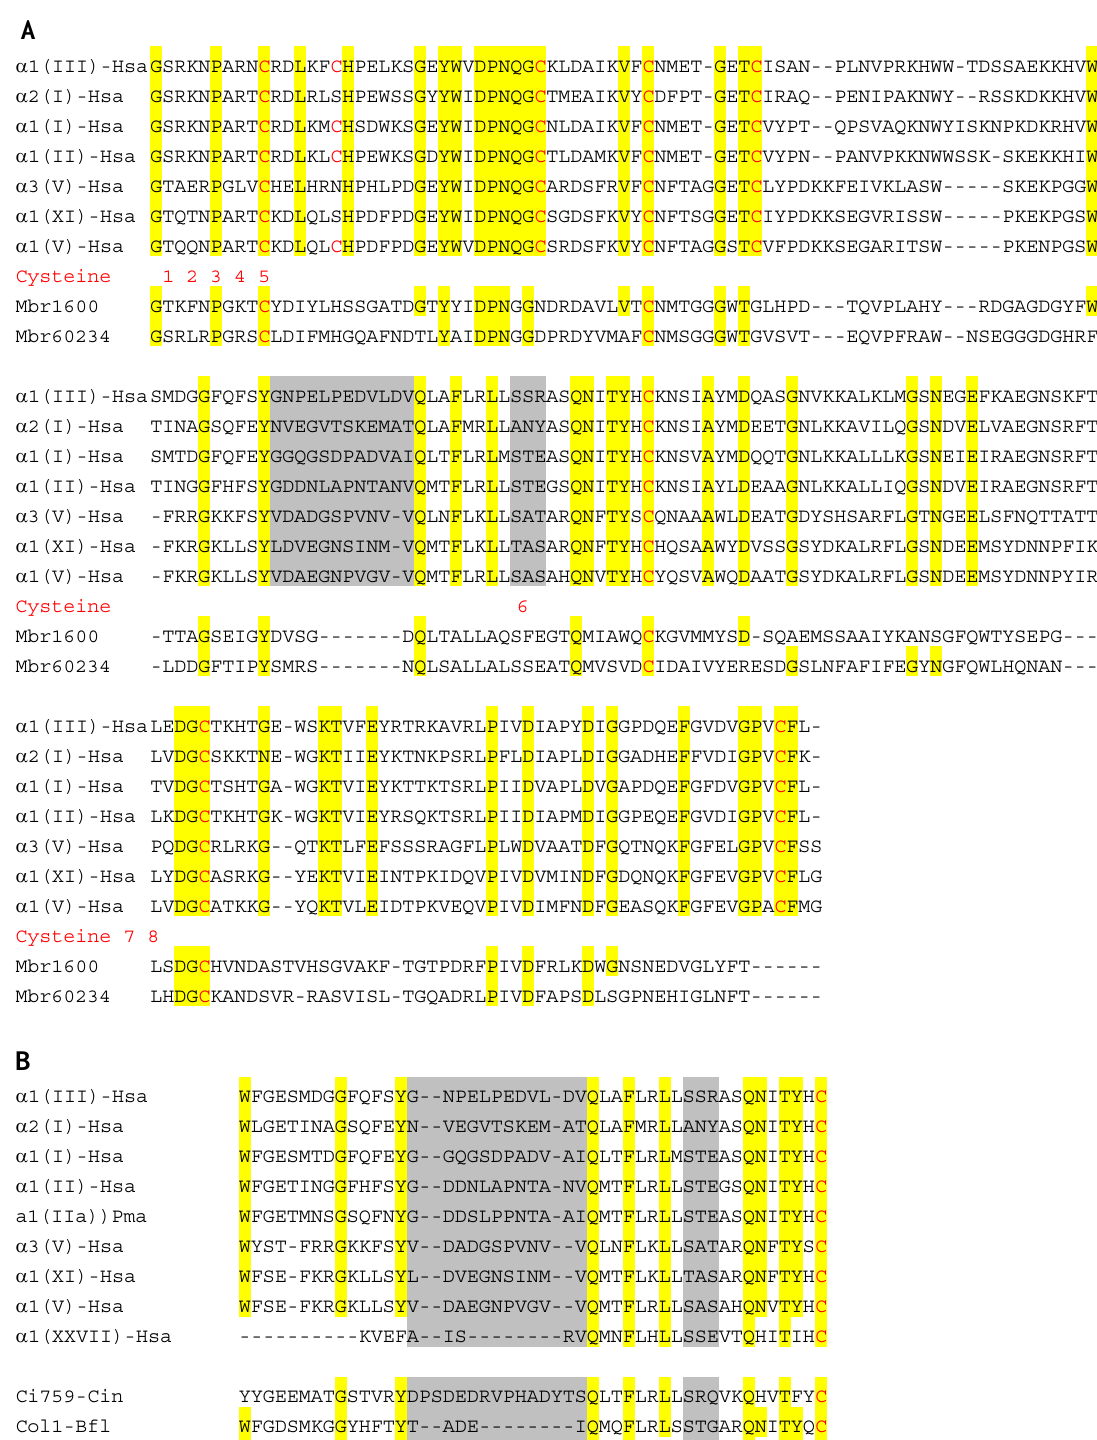
Figure 2. Multiple alignments of C -propeptide (COLF1) domains. ( A ) Selected human (Hsa) and choanoflagellate (Mbr, Monosiga brevicolis ) COLF1 domains are aligned. Residues that are perfectly conserved among these proteins are shaded in yellow. Cysteine residues are colored in red and numbered. The grey boxes represent the chain selectivity recognition domains identified by Lees et al . [24]. ( B ) Chain recognition sequences in Metazoa. This sequence alignment is based on previous studies